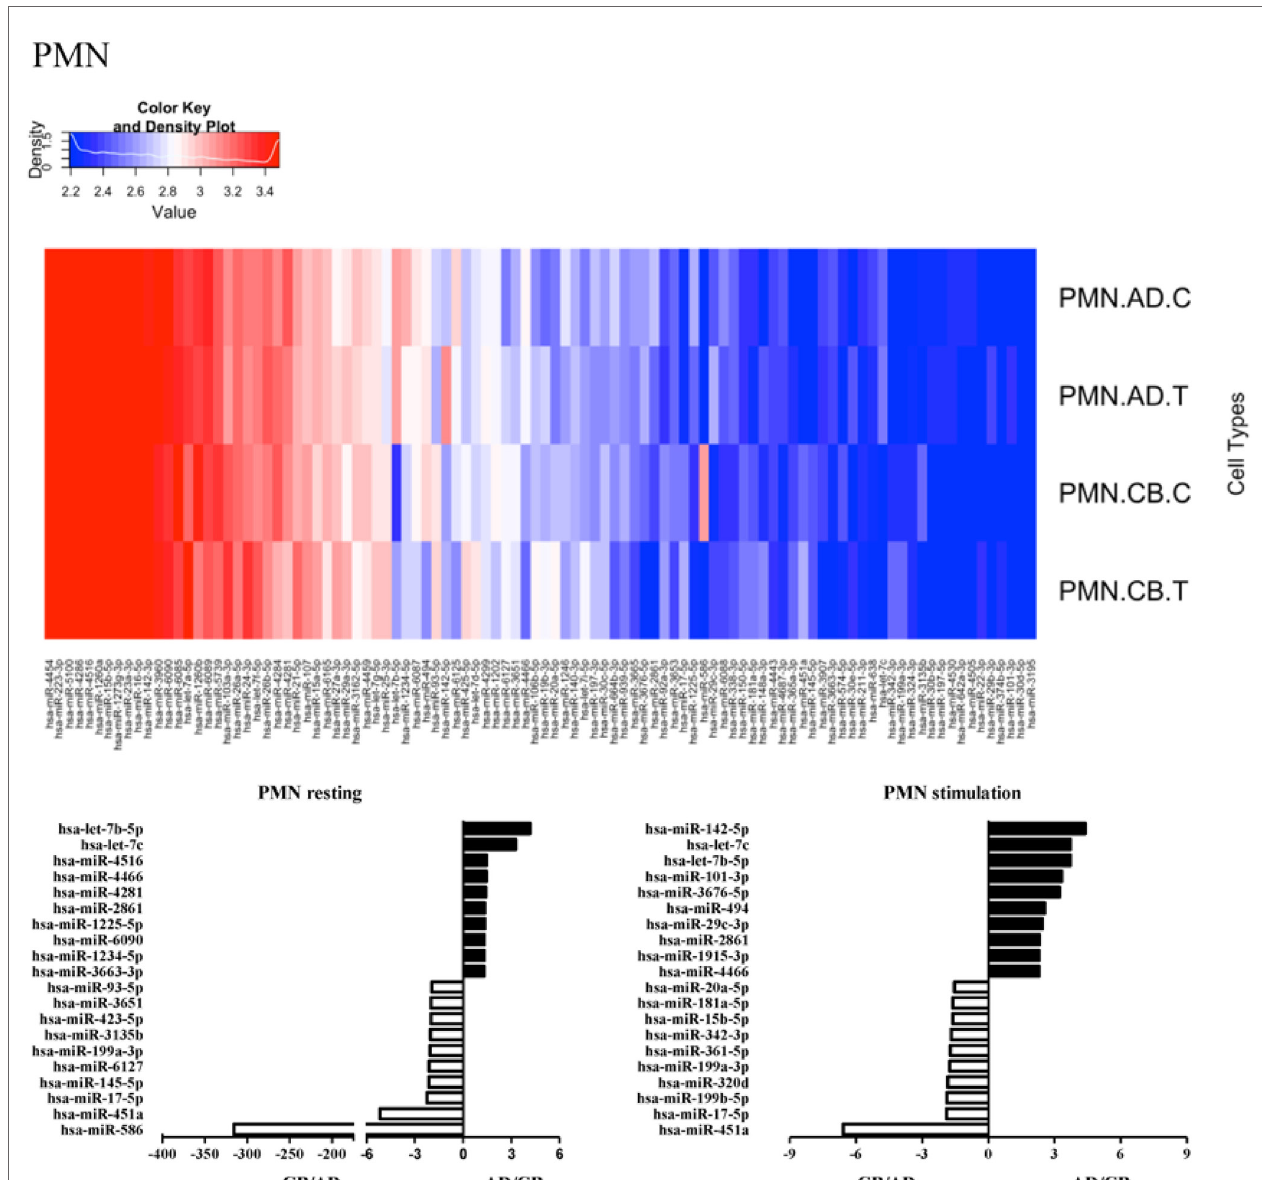
FigUre 3 | Differential microrna (mirna) profiles between adult and neonatal polymorphonuclear cells (PMns) . Upper heat map showing distinct miRNA expression in activated and resting leukocyte subsets of adult peripheral blood and cord blood. Each heat map lane represents the top 100 expressed miRNAs in each leukocyte subset. Higher intensity is shown in red and lower intensity in blue. Lower bar charts showing the top 10 differentially expressed miRNAs in adult (black bar) or (white bar) neonate cells in specific leukocytes at resting (left) or activated states (right). The expression of miRNAs is represented as relative folds. Has, Homo sapiens